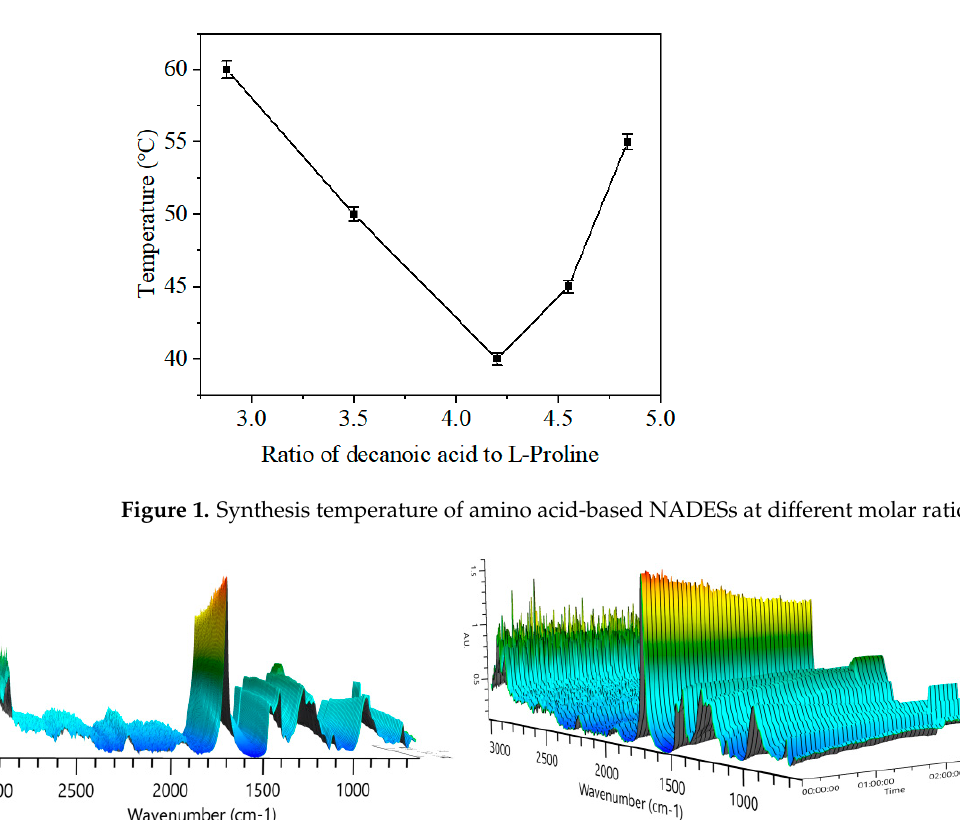
Figure 2. In situ IR spectra of preparation process of amino acid-based NADESs.